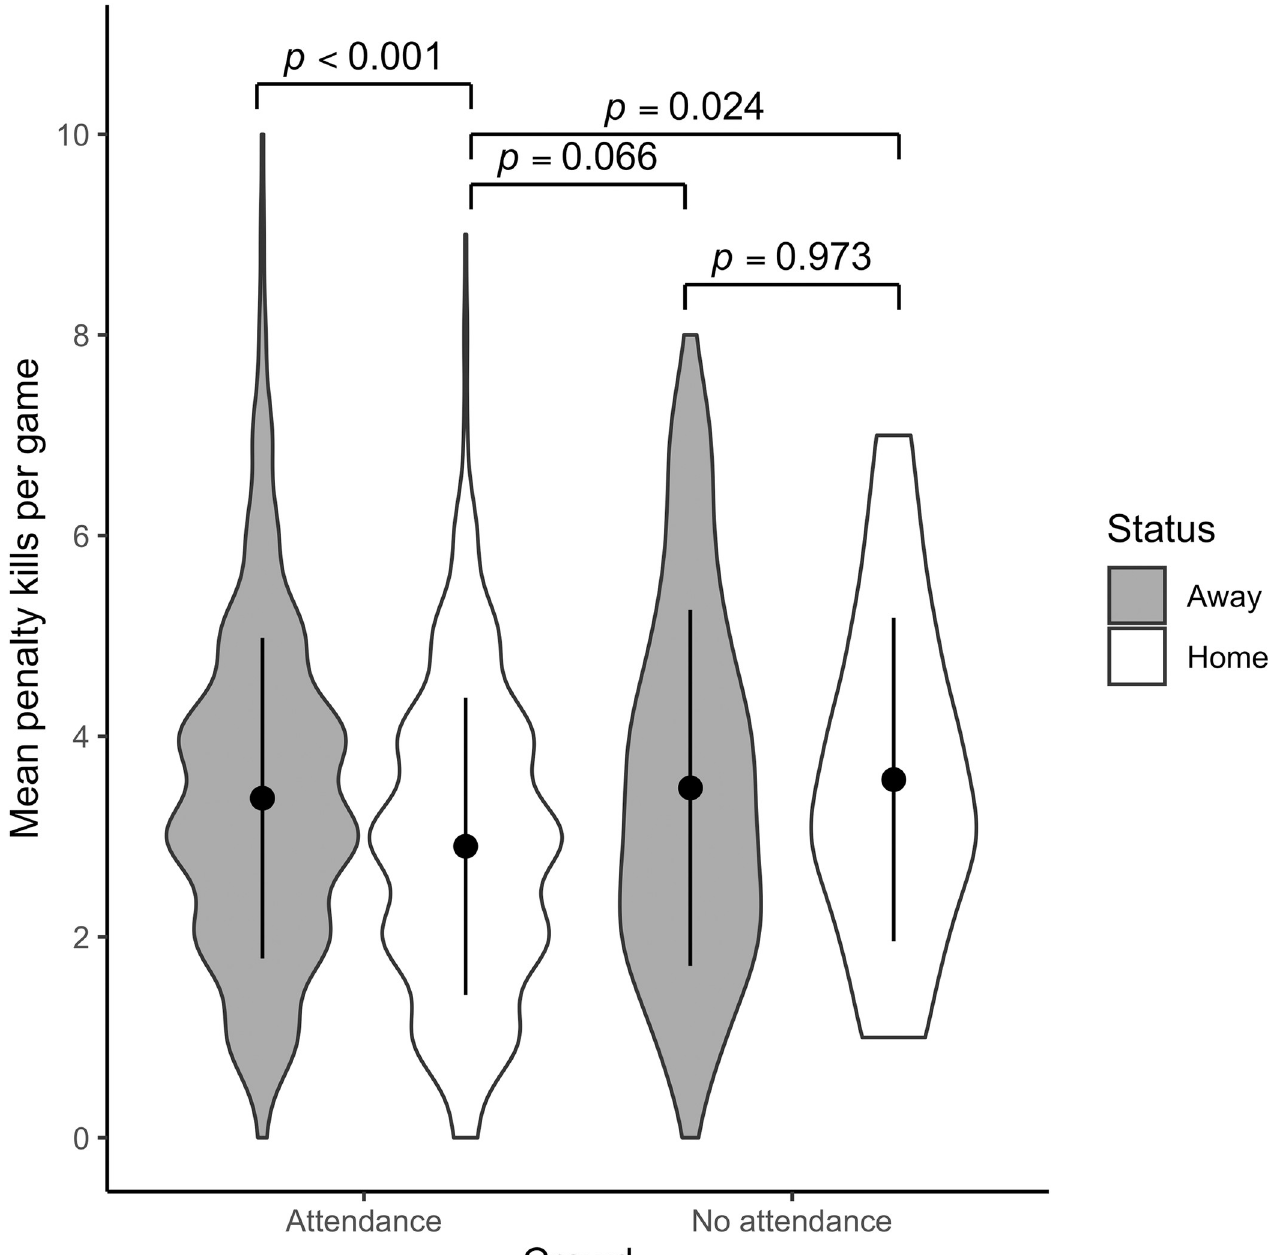
Fig 1. Mean penalty kills per team with and without attendance during the NHL playoffs. For the sake of simplicity, the raw data have been presented in the figure, even though the model results in Tables 2 and 3 are in log-odds.